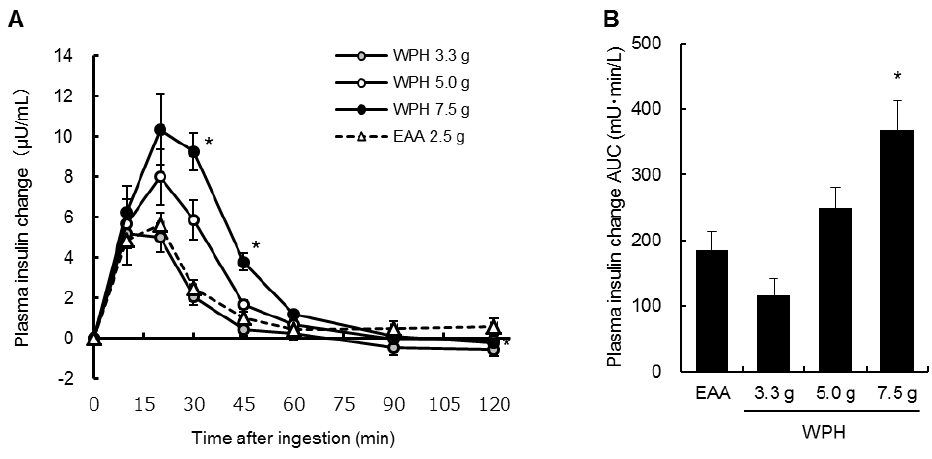
Figure 4. Plasma insulin concentration ( A ) changes from baseline and ( B ) AUCs. Values are mean ± standard error of the mean. * Significantly different from EAA, p < 0.05. AUC: area under the curve; WPH: whey protein hydrolysate; EAA: essential amino acids.